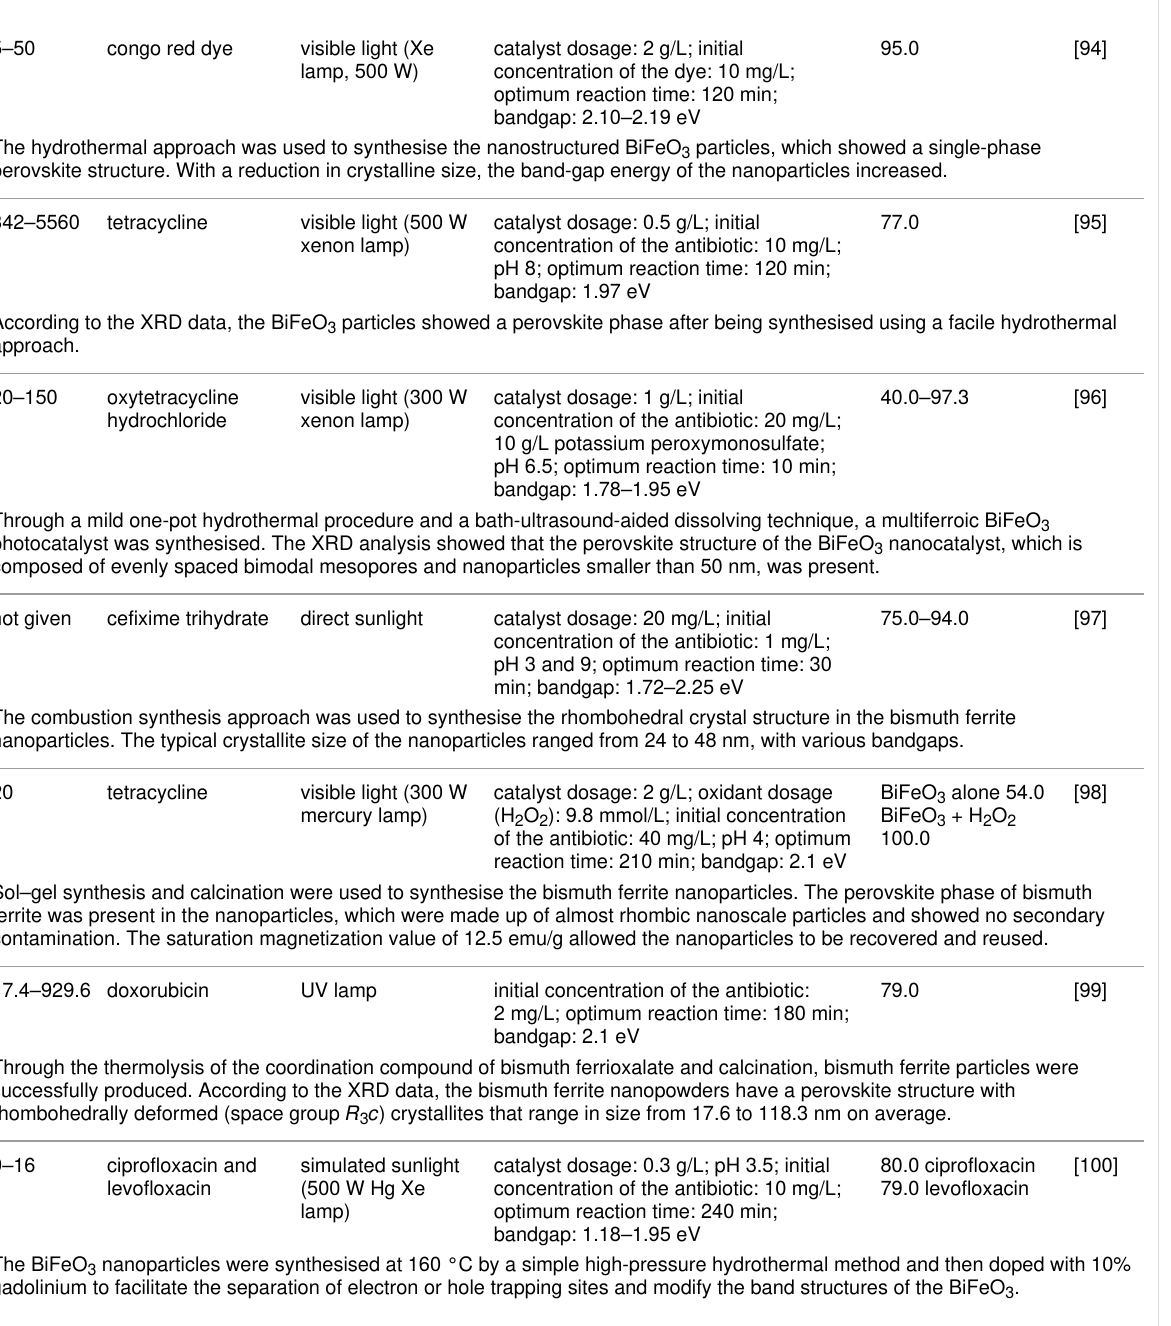
Table 2: Treatment of water containing antibiotics and dyes by bismuth ferrite nanoparticles (BiFeO 3 ). (continued)